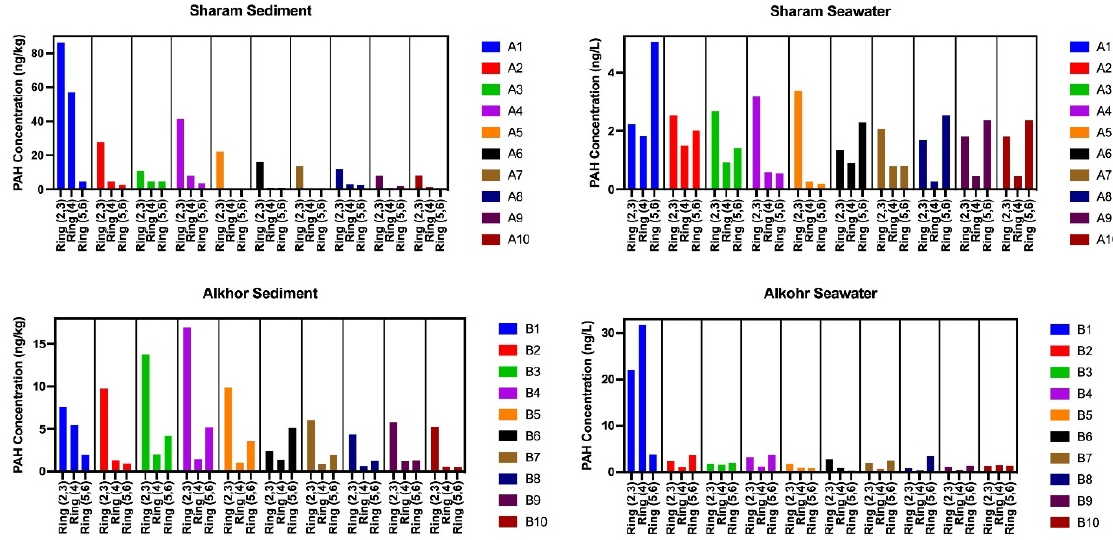
Figure 3. Concentrations of PAHs with different numbers of rings in the water and sediment samples from the Sharam area and Alkhor area.